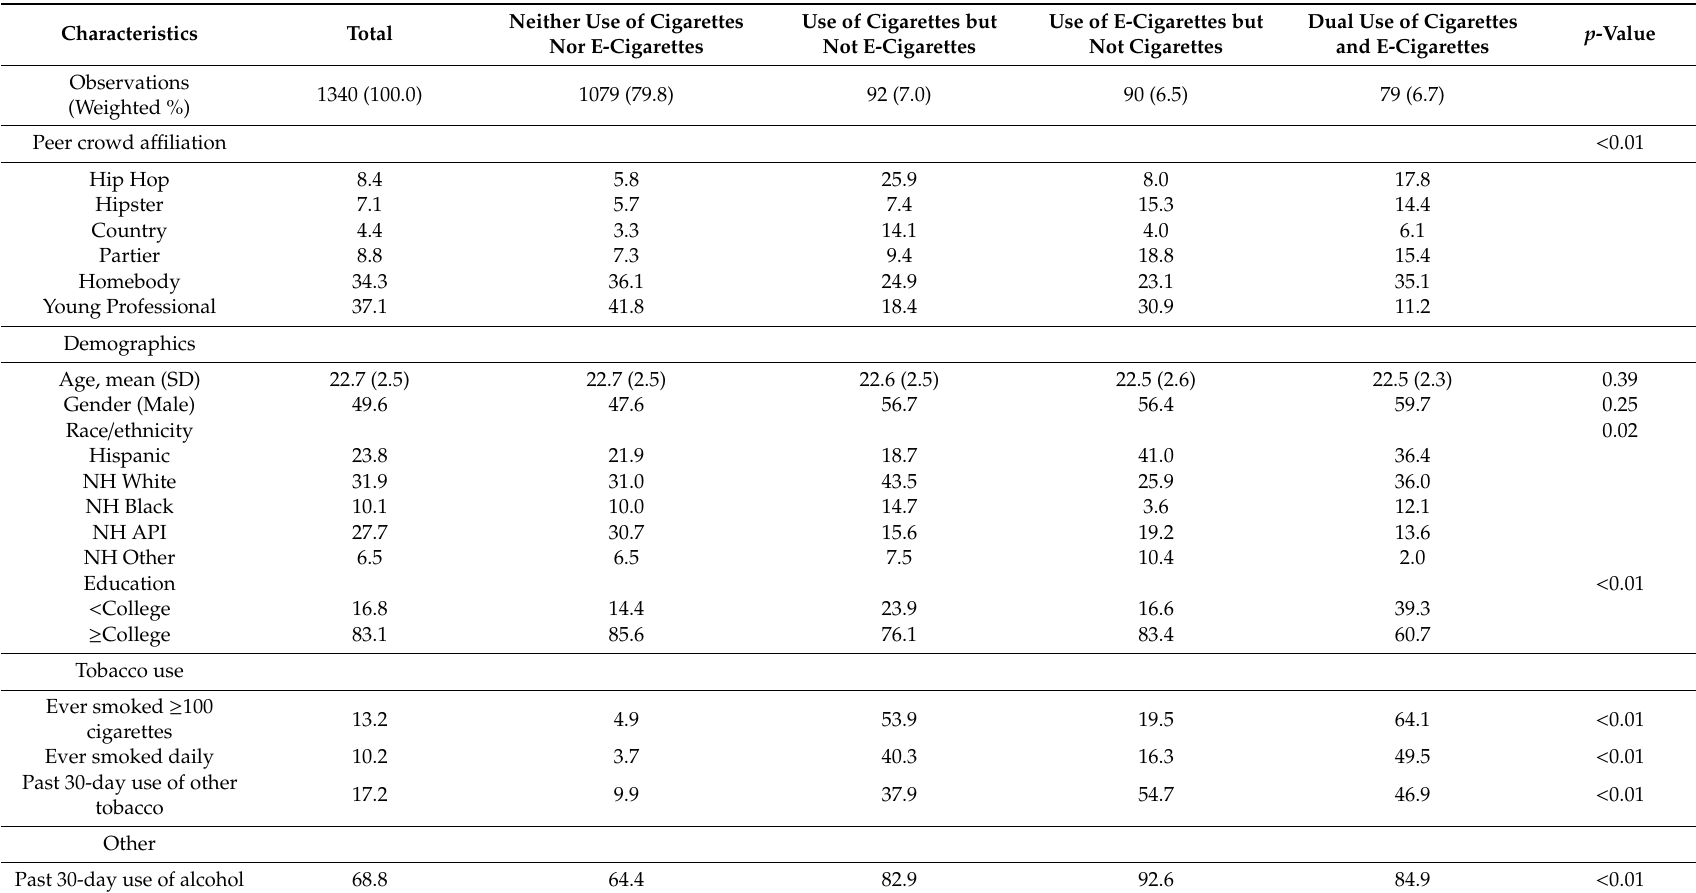
Table 1. Sample characteristics (weighted